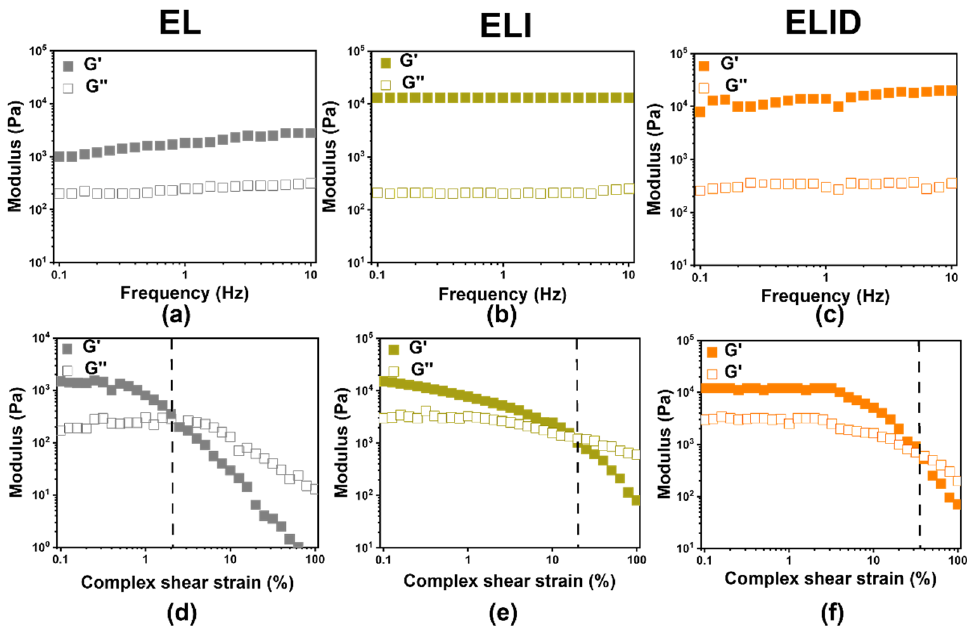
Figure 2. The frequency sweep ( a – c ) at γ = 0.5% constant oscillatory strain and f = 0.1–10 Hz; amplitude sweep ( d – f ) oscillatory strain (0.1–100%) at a constant frequency ( f = 1 Hz) (the dotted lines are fractured point) ( n = 3).